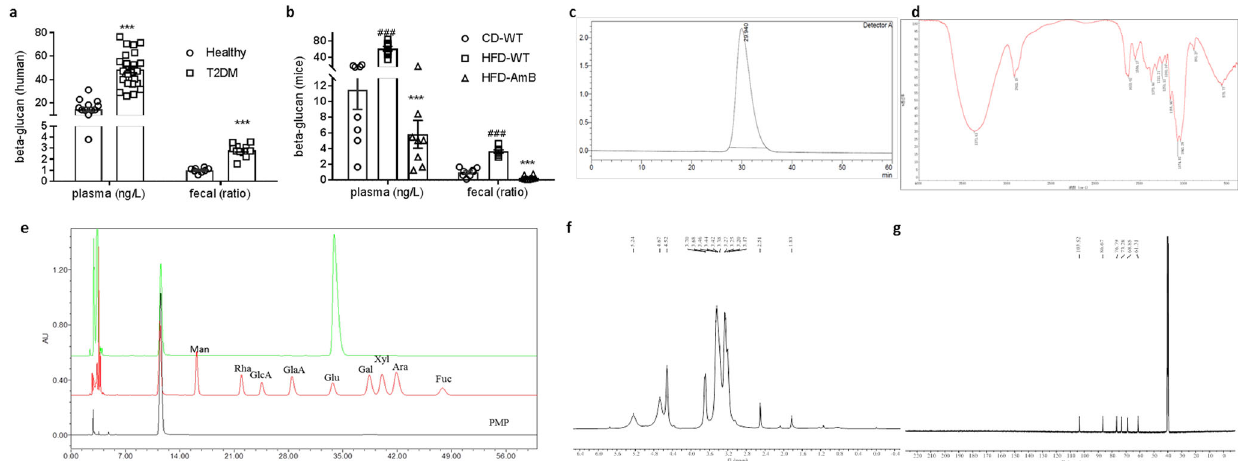
Fig. 4 The characterization of 1,3- β -glucan isolated from C. albicans . 1,3- β -glucans content of plasma (healthy group: n = 15, T2DM group: n = 26) and fecal (healthy group: n = 8, T2DM group: n = 12) in human ( a ) and mice ( b , n = 8), c – g HPGPC, FT-IR and NMR in DMSO- d 6 spectrum of 1,3- β -glucan isolated from C. albicans . e The monosaccharide composition of CAG was determined by HPLC, red line: a standard mixture, green line: CAG acid-hydrolyze and black line: PMP derivate. Statistical analysis was done using one-way ANOVA followed by the Tukey post hoc test. *** P < 0.001 vs healthy group (A) and *** P < 0.001 vs HFD-WT group, and ### P < 0.001 vs CD-WT